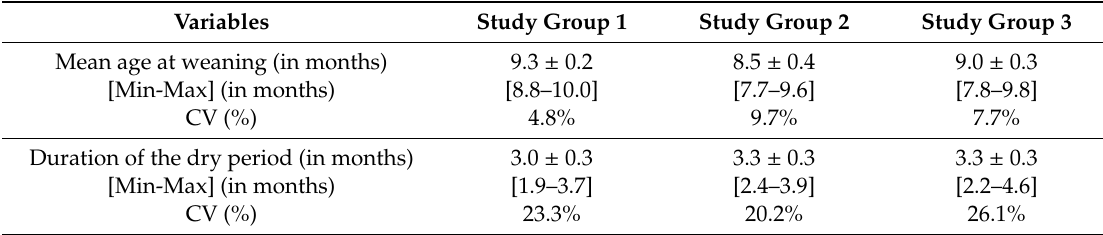
Table 3. Foal weaning and inter-group variations: age of foals and duration of the dry period. Variables Study Group 1 Study Group 2 Study Group 3 Mean age at weaning (in